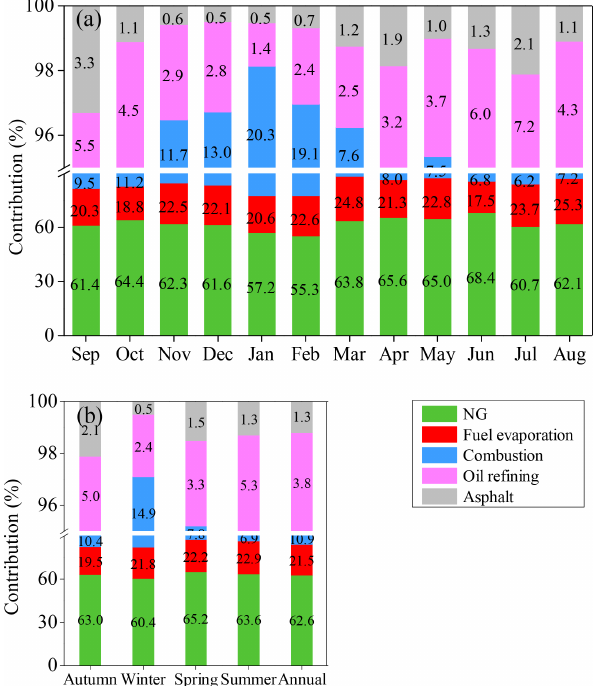
Figure 11. Variation in monthly averaged (a) and seasonally aver- aged (b) contributions of five identified VOC sources (expressed as a